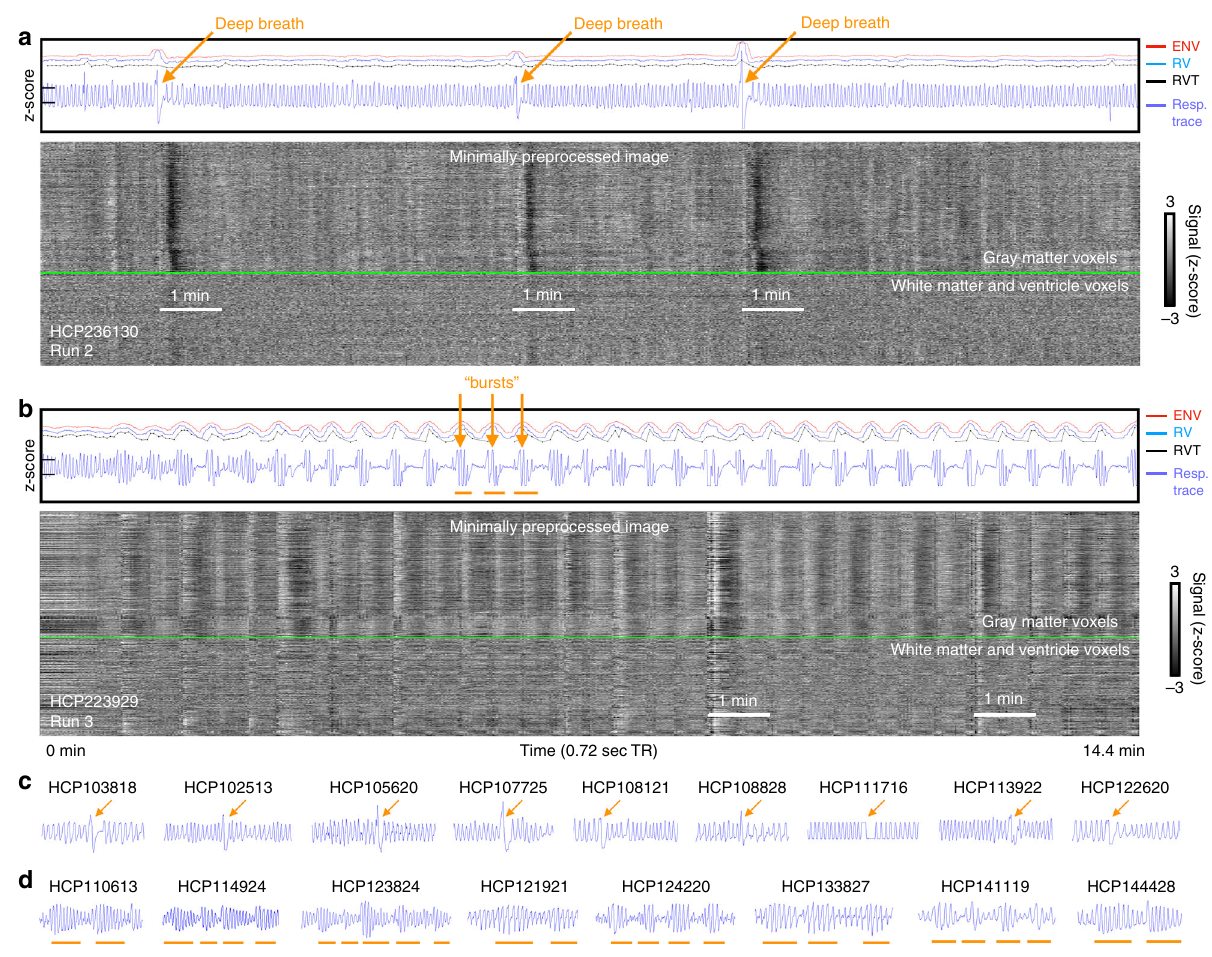
Fig. 1 Gray plots of scans containing deep breaths and bursts. Gray plots containing a deep breaths and b bursts. Upper panels show the z -scored respiratory belt traces in blue ( y -ticks at left are z = − 1 and 1), and 3 commonly derived respiratory measures (ENV, RV, and RVT, with vertical offsets to enable non-overlapping visualization; scales are identical in all fi gures). In the grayscale heat maps, all in-brain fMRI signals are shown organized by anatomical compartment, with a green line separating gray matter from white matter and ventricle signals. In a , three deep breaths are indicated by arrows, with major decreases (vertical black bands) in fMRI signal following each of the breaths. In b , over two dozen bursts are present (arrows mark several), with accompanying modulations of fMRI signals. Supplementary Figs. 1 and 2 show comprehensive versions of each scan. Additional exemplars of deep breaths ( c ) and bursts ( d ) are shown at the bottom. The code to produce gray plots was published in ref. 49 , and comprehensive gray plots of all 17,640 scans are shown in Supplementary Movie